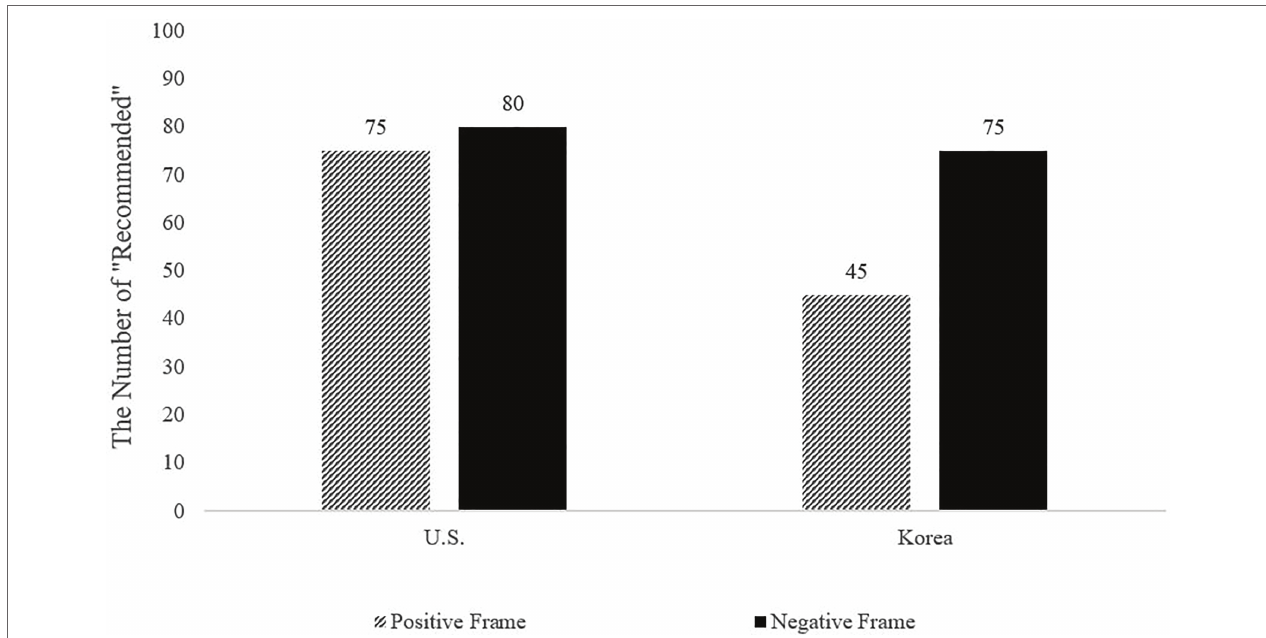
FIGURE 3 | Infection effect of frame × country on the number of “Recommended” reviews needed for purchase (Study 2).